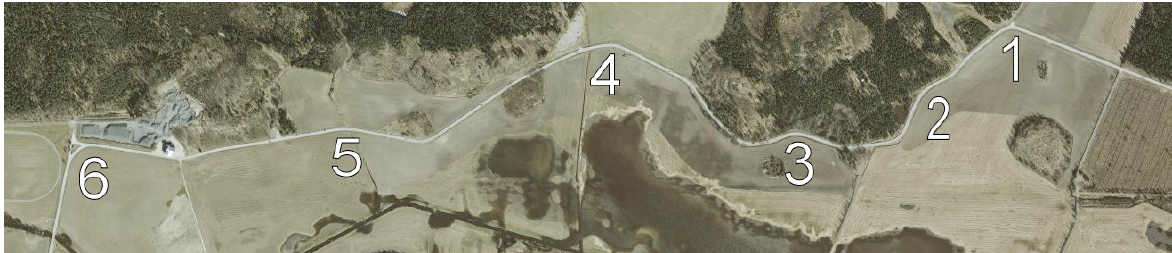
Figure 1. The route used in the study (N60 o 36’58’’, E24 o 44’19.37’’). The turns analyzed in this study are numbered 1-6 (east-to- west). Image source: National Land Survey of Finland open database.